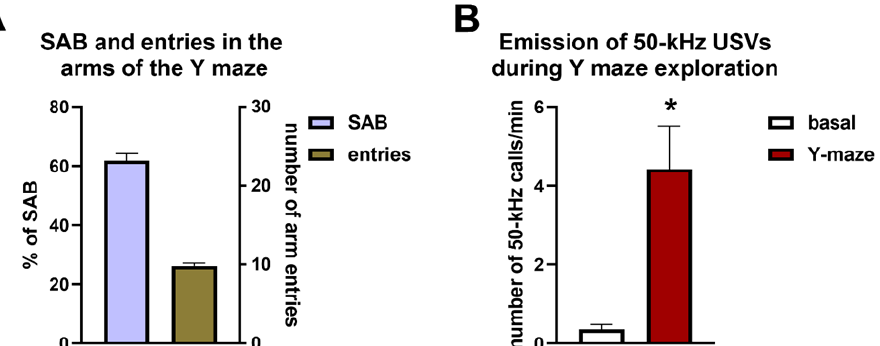
Figure 6. Panel A demonstrates the percentage of spontaneous alternation behavior (left Y axis) and the number of entries in the arms of the Y maze (right Y axis) for all the rats tested. Panel ( B) demonstrates the emission of 50-kHz ultrasonic vocalizations recorded during Y maze exploration in all the rats tested. * Indicates a significant difference vs. basal. SAB = spontaneous alternation behavior; USVs = ultrasonic vocalizations. n = 40 for panel ( A ); n = 38 for panel B. Spearman’s test revealed the existence of positive but not significant correlations between the percentages of SAB and: (i) the overall number of 50-kHz USVs (total calls); (ii) the number of flat 50-kHz calls; (iii) the number of FM 50-kHz calls, emitted during Y maze exploration (total calls: r = 0.23, p = 0.16; flat calls: r = 0.12, p = 0.44; FM calls: r = 0.25, p = 0.13) (Figure 7A–C). Conversely, Spearman’s test revealed that significant positive correlations existed between the number of entries in the arms of the Y maze and: (i) the overall number of 50-kHz USVs (total calls); (ii) the number of flat 50-kHz calls; (iii) the number of FM 50-kHz calls, emitted during Y maze exploration (total calls: r = 0.55, p < 0.01; flat calls: r = 0.49, p < 0.01; FM calls: r = 0.54, p < 0.01) (Figure 7D–F). One-way ANOVA revealed no differences in both the percentages of SAB (F3,76 = 0.68, p > 0.05) (Figure 8A) and the number of entries in the arms of the Y maze (F3,76 = 1.49, p > 0.05) (Figure 8B) when rats were divided in three groups based on the prevalent type of USVs (i.e., 22-kHz or 50-kHz calls) emitted in response to tickling. Nevertheless, rats that emitted more 22-kHz calls than 50-kHz calls in response to tickling displayed a trend towards a reduction in the number of arm